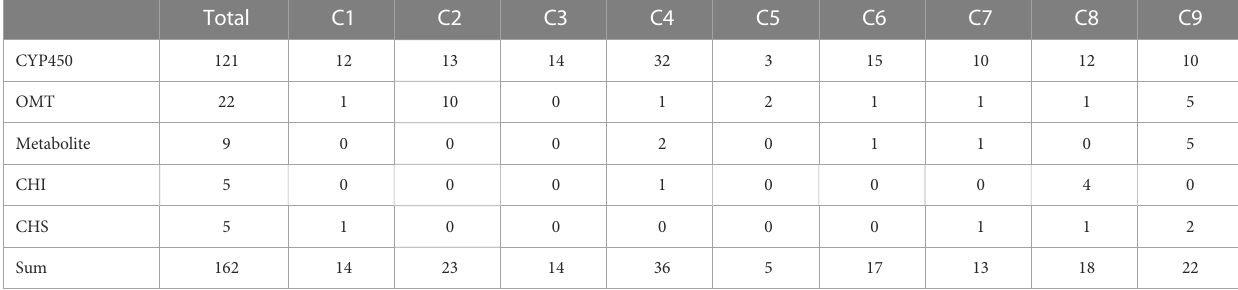
TABLE 2 Summary of clustering analysis results divided into 9 clusters.